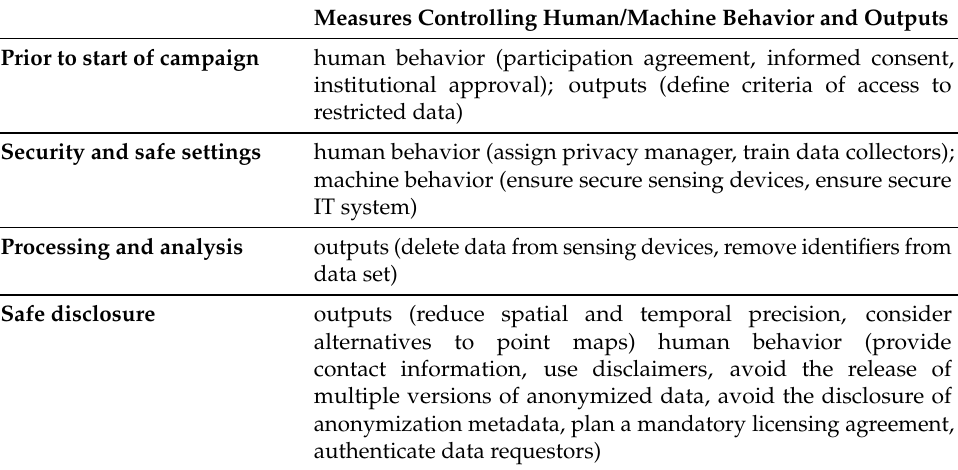
Table 2. Examples of measures controlling the transformation